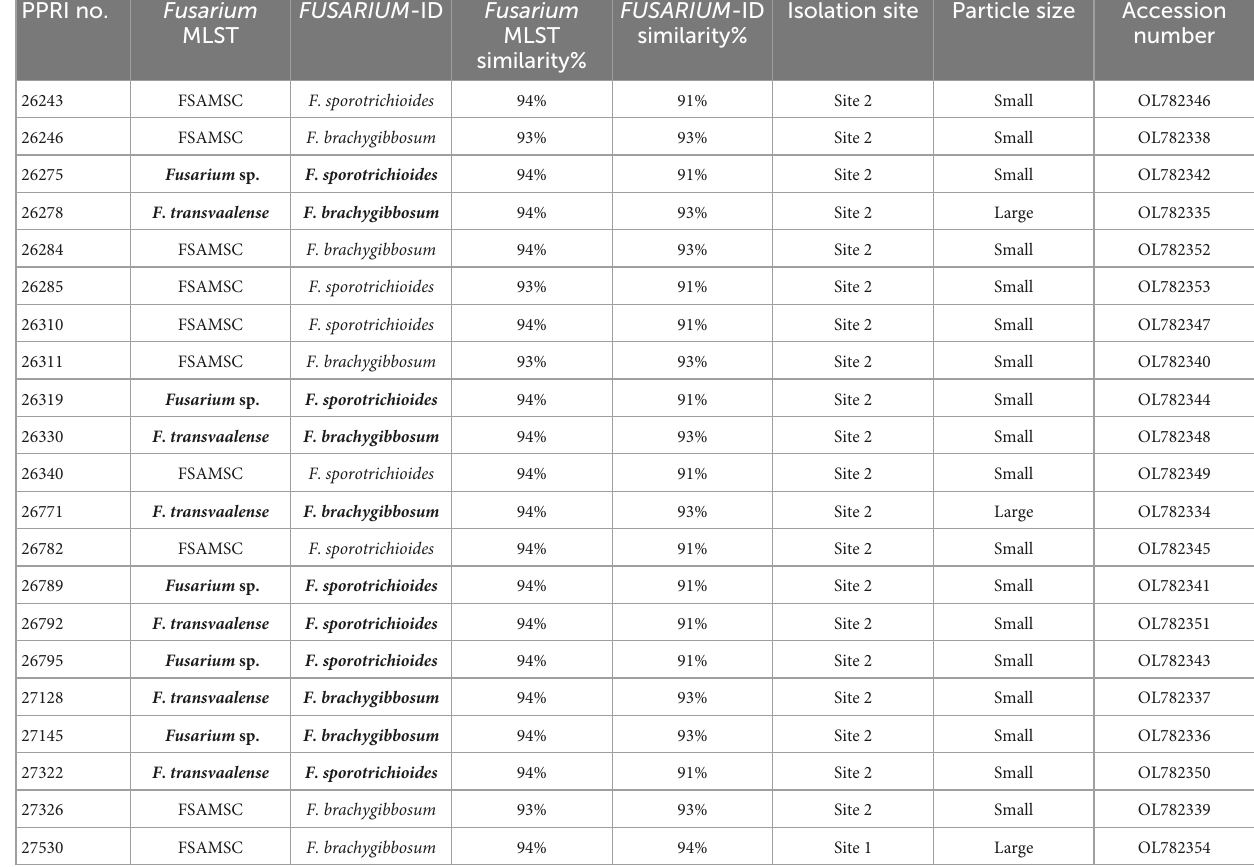
TABLE 3 Nucleotide BLAST (nBLAST) results from the Fusarium MLST and FUSARIUM -ID databases for the FSAMSC. PPRI